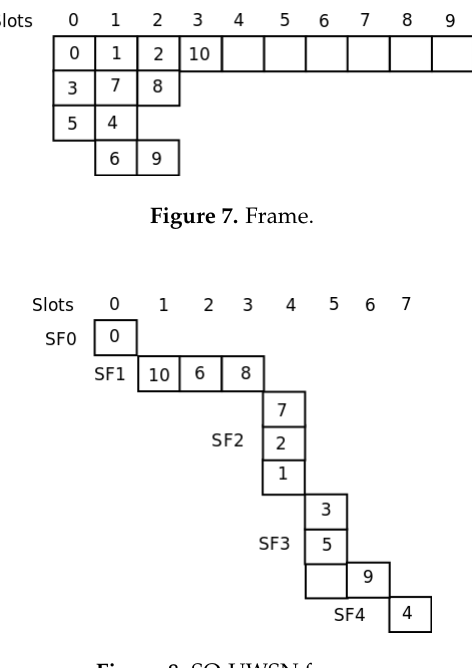
Figure 8. SO-UWSN